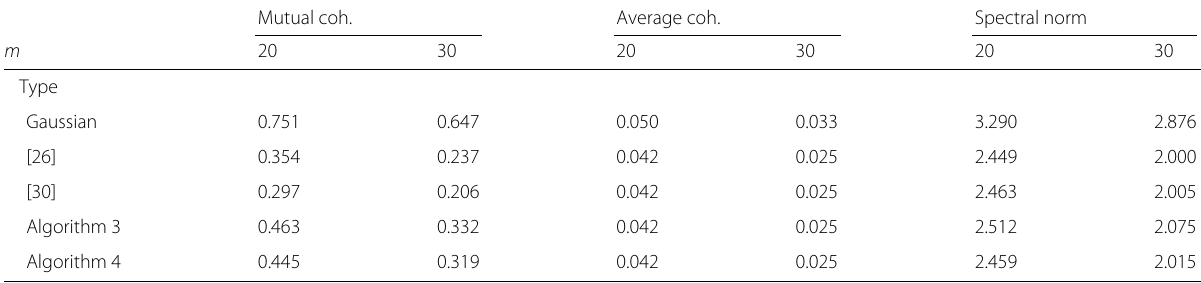
Table 3 Properties of sensing matrices employed in CS experiments Mutual coh. Average coh.